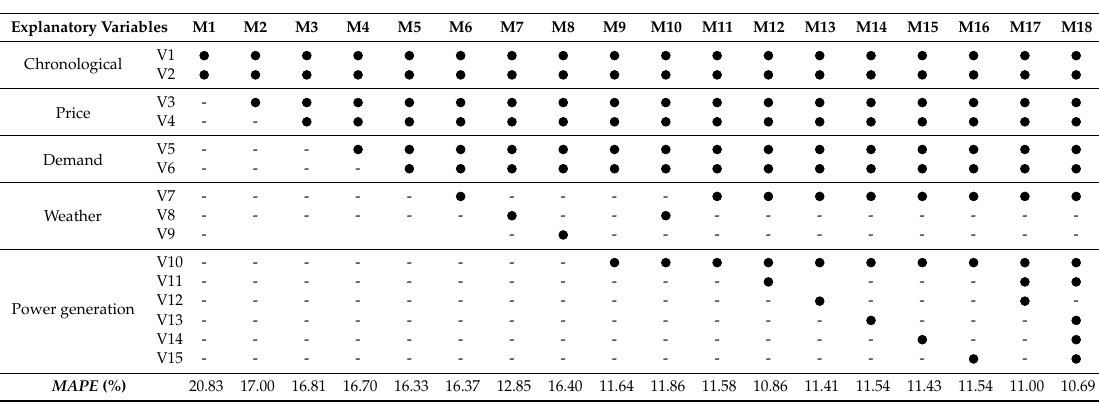
Table 6. DSMPF models and their MAPEs .